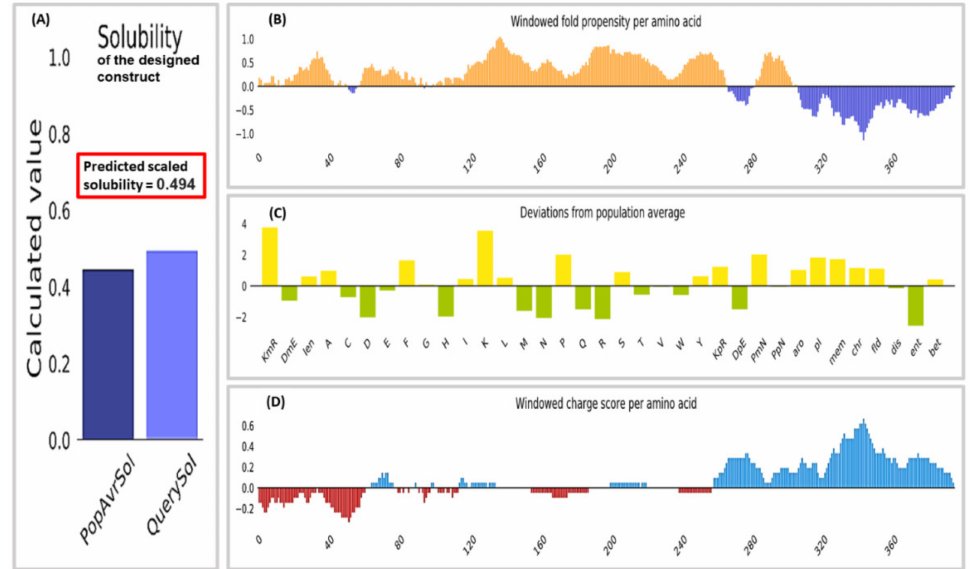
Figure 3. Solubility analysis of the multiepitope construct conducted using the protein-sol server. ( A ) Solubility plot of the designed construct alongside the population average for the investigational dataset. The solubility of the designed construct was calculated to be 0.494. ( B ) Windowed fold propensity. ( C ) Plot shows deviations from population averages for 35 features. ( D ) Windowed net charge.